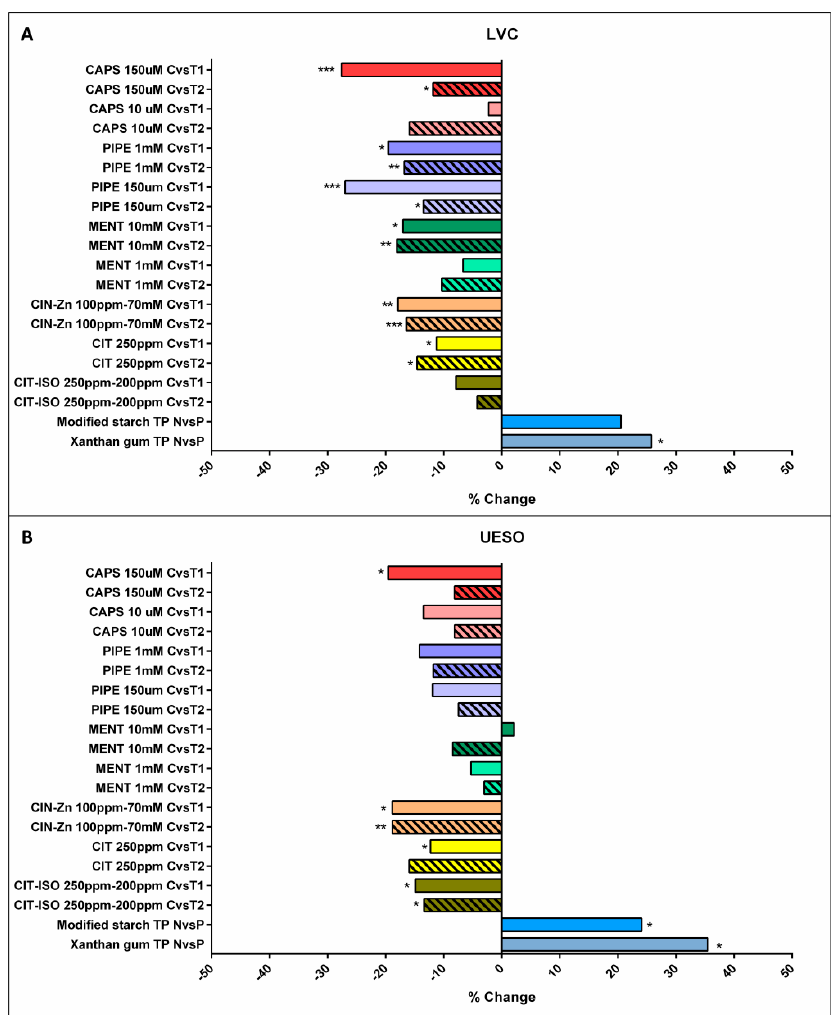
Figure 2. Normalized effect of compensatory and active treatments on the time to LVC ( A ) and to UESO ( B ). LVC: laryngeal vestibule closure; UESO: upper esophageal sphincter opening; CAPS: